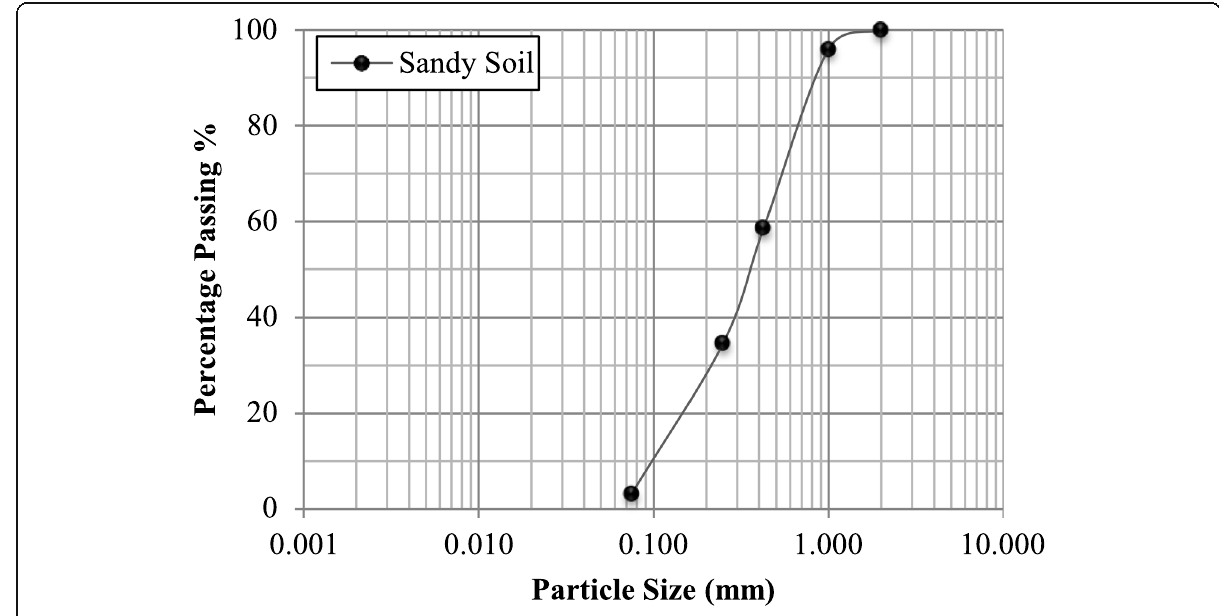
Fig. 9 Sieve analysis of soil